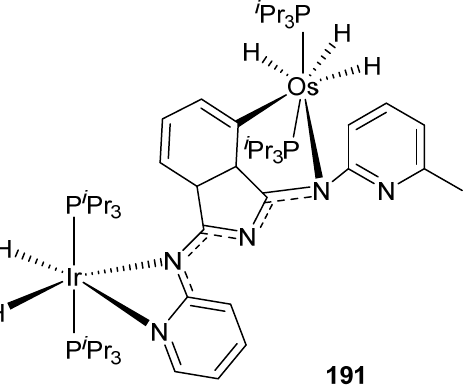
Figure 44. Heterobimetallic complex used in dehydrogenation of secondary alcohols.